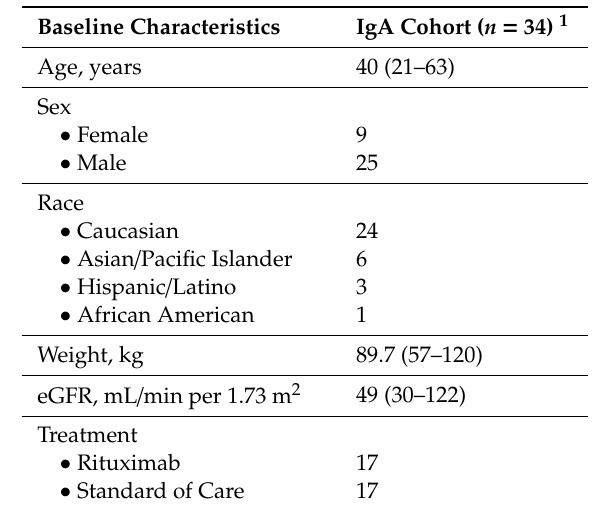
Figure 1. Study design and patient disposition. (Left) In the original trial, 34 patients met inclusion criteria and were randomized into Rituximab and standard of care treatment groups. At least one urine sample was available from 28 of the 34 patients, with 14 having urine samples at all three designated time-points. (Right) Pictorial depiction of patients, treatment, and sample availability. Patients were segregated based on treatment, either with standard of care (turquoise) or Rituximab (coral), with individual patients as rows. A yellow square indicates a urine sample was available at the indicated time-point, while gray indicates that no urine sample was available for analysis due to failure to collect or insufficient sample volume. Table 1. Baseline characteristics of IgA nephropathy (IgAN) patients.